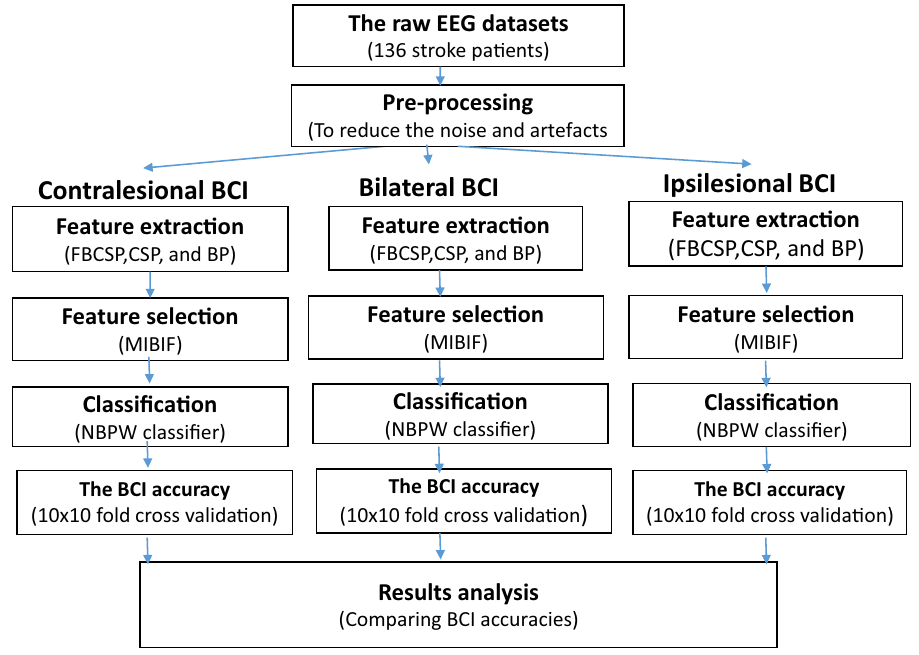
Figure 5. Flowchart presenting the steps taken for training and evaluating the BCI models. BP band power, CSP common spatial patterns, FBCSP filter bank common spatial patterns, MIBIF mutual information-based best individual feature selection, NBPW Naive Bayesian Parzen